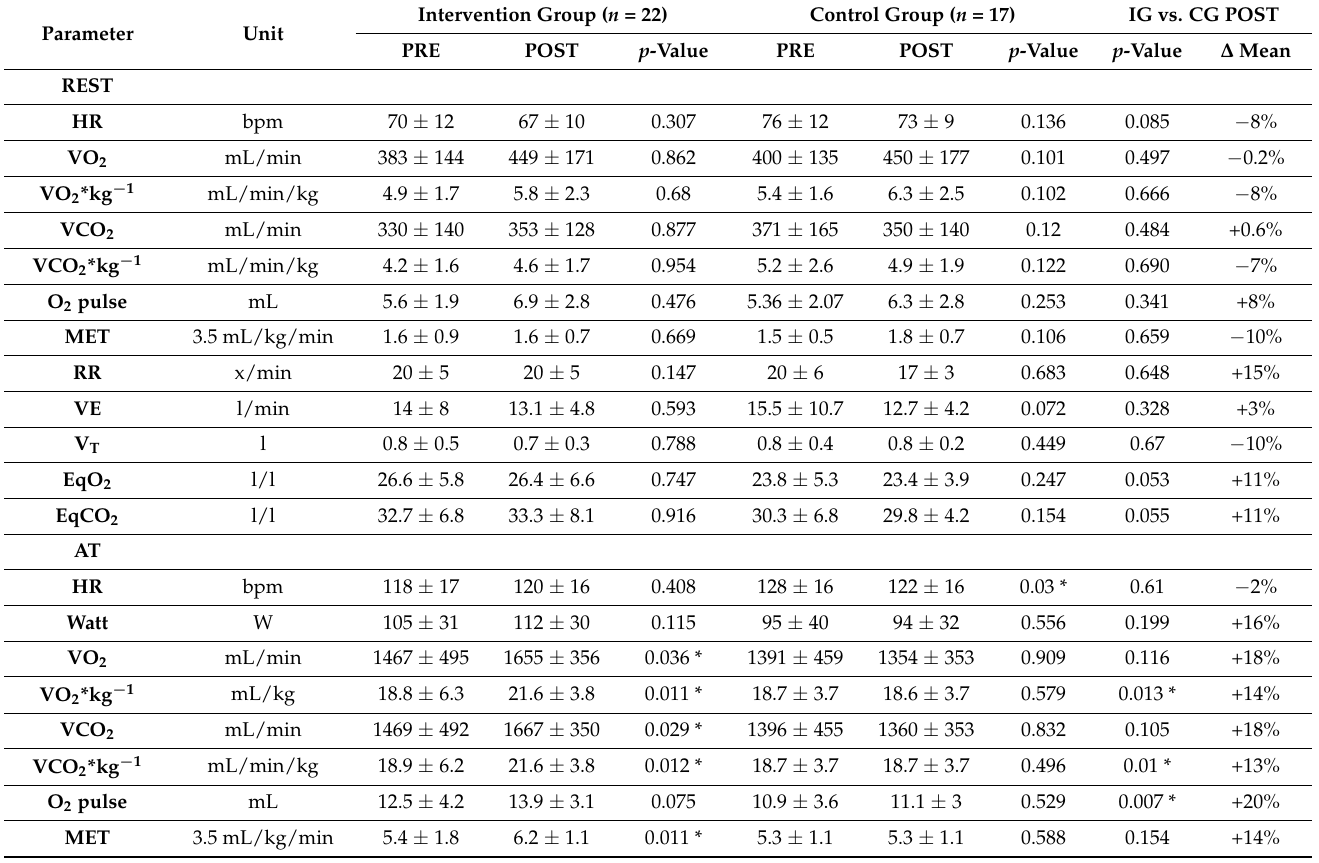
Figure 1. Graphical abstract summarizing the findings of this study. Table 2. CPET ‐ results at REST, AT, and MAX in PRE – POST comparison.